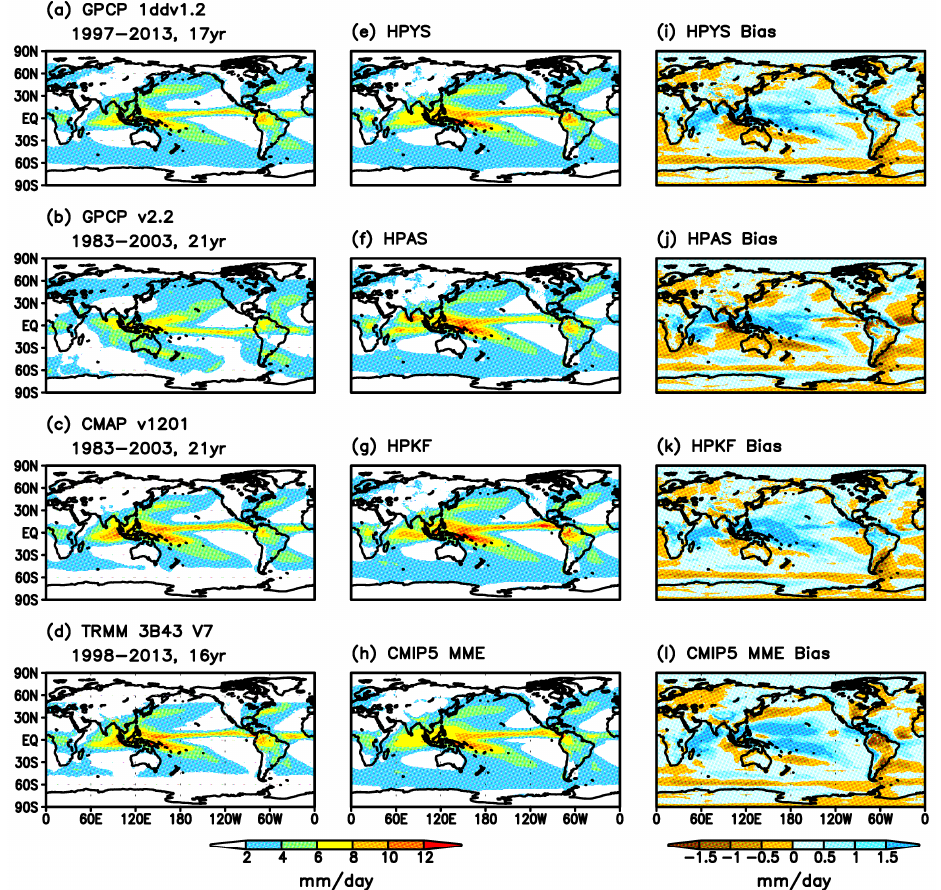
Figure 2. The climatology of annual average precipitation (PAV). Unit is mm day − 1 . ( a – d ) Observation (Table 2); ( e – h ) simulations by models averaged for 1983–2003 (21 years); ( e ) HPYS; ( f ) HPAS; ( g ) HPKF; ( h ) MME mean of 24 CMIP5 atmospheric models’ Atmospheric Model Intercomparison Project (AMIP) runs (Table S1); ( i – l ) bias against GPCP 1ddv1.2 (a). GPCP, Global Precipitation Climatology